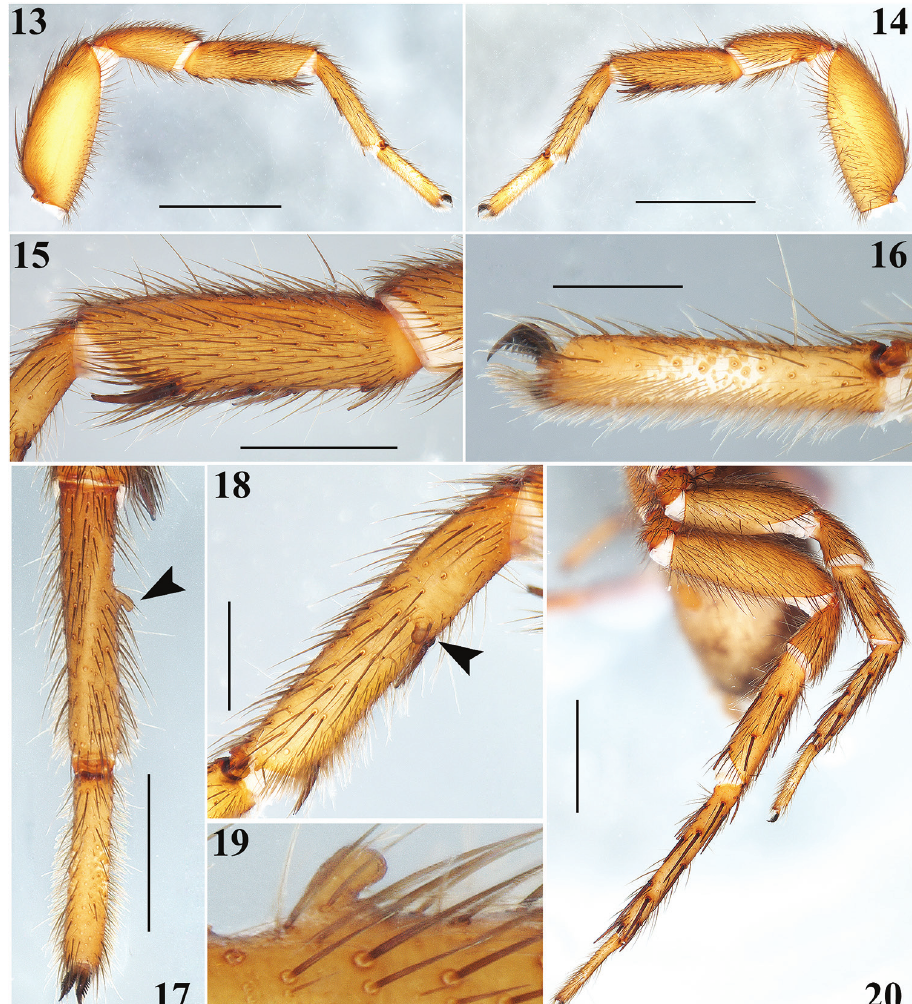
Figures 13–20. Aptostichus sabinae sp. n. Male holotype: 13–14 Left leg I, prolateral and retrolateral views respectively 15 Tibia I, retrolateral view 16 Tarsus I, retrolateral view 17 Metatarsus and tarsus I, dorsal view (arrow indicates the small finger-shaped projection on retrolateral-ventral part of metatarsus) 18 Metatarsus I, retrolateral view (idem) 19 Detail of the small finger-shaped projection on retrolateral- ventral part of metatarsus I. 20 , Spination pattern on legs III and IV. Scale bars 0.2 mm ( 19 ), 0.5 mm ( 16 , 18 ), 1 mm ( 15 , 17 ), 2 mm ( 13 , 14 , 20 ). I: v(2+2+2) (one of the last spines -retrolateral- is massive) (Figs 14, 15), p(1) (Fig. 13); tibiae II: v(2+2+2), p(1+1); metatarsi I: v(2+1); metatarsi II: v(1+2+2), p(1). Leg III and IV spination pattern is illustrated in Figure 20. Pedipalps: Articles pale orange, slender, femora and tibiae with long setae ventrally (Figs 8, 9). Patellae with distal dorsal-prolateralspine. Tibiae with massive ventral and prolateral spines (Figs 8,